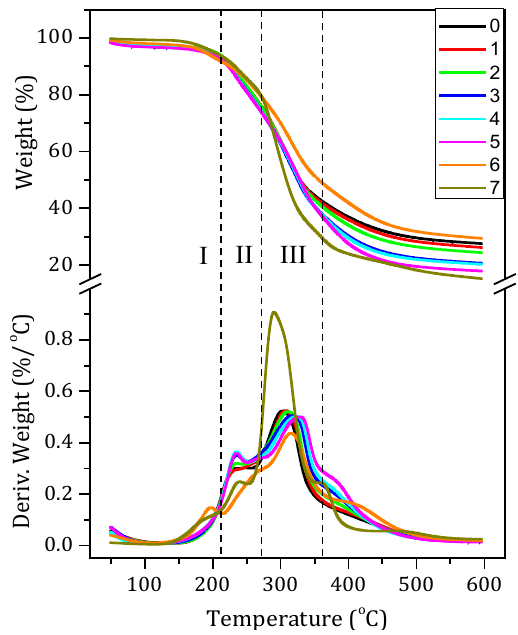
Figure 3. The thermogravimetric (TG) and derivative thermogravimetric (DTG) curves of the different adhesives: 0 (SM adhesive), 1 (SM/SDS adhesive), 2 (SM/SDS/NGDE-2 adhesive), 3 (SM/SDS/NGDE-4 adhesive), 4 (SM/SDS/NGDE-6 adhesive), 5 (SM/SDS/NGDE-8 adhesive), 6 (SM/PAE adhesive), and 7 (MUF resin). I: Possible post-reaction stage, II: Initial degradation stage,